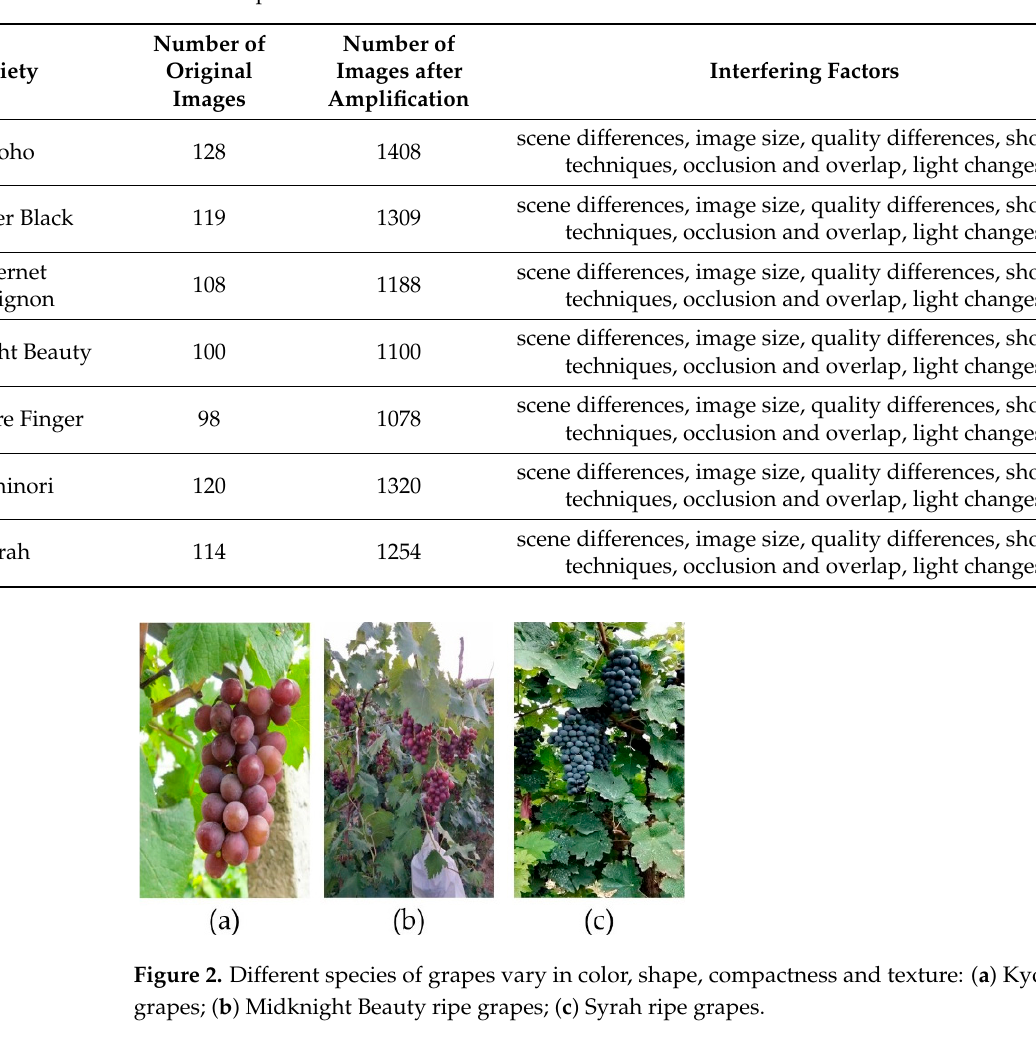
Table 1. Grape-internet dataset information.